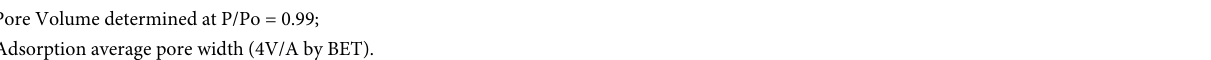
The external morphology of SBC and MSBC at both 5000 and 10000 magnifications are presented in S2 Fig. Obvious pore structures were observed on the surfaces of both SBC and MSBC. However, the conspicuous particles were only distributed on the surface of MSBC (S2 (c) and S2(d) Fig) but not SBC. These particles could be confirmed as iron oxides based on the above XRD analysis and SEM-EDS images in Fig 1. In addition, significant reduction of pore width on the surface of MSBC can be observed due to the occupation of iron compounds into the pores of adsorbents. This phenomenon was in agreement with the results of BET analysis (Table 1). The SEM-EDS images are presented in Fig 1, which revealed the characteristics of iron and Ni distribution on the surface of SBC and MSBC. It was observed that iron com- pounds distributed on the surface of SBC and MSBC and the iron percentage of MSBC was distinctly higher than that of SBC due to the fabrication process. It was worth noting that the Ni adsorption amount of MSBC was evidently higher compared with SBC (Fig 1). Further- more, the Ni distribution locations appeared nearly consistent with the locations of the iron distribution. This provided evidence for the positive effects of α -Fe O and α -FeOOH micro 2 3 particles on Ni adsorption.